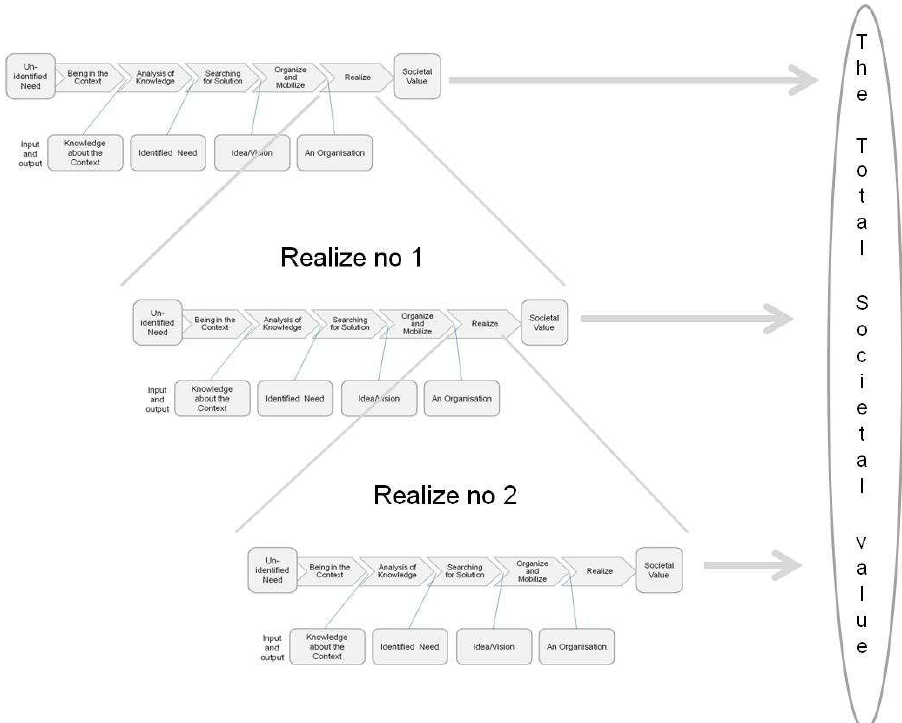
Figure 5 – A suggestion for a general visualization of realization of societal entrepreneurship. To see the text in sub processes, input and output see Figure